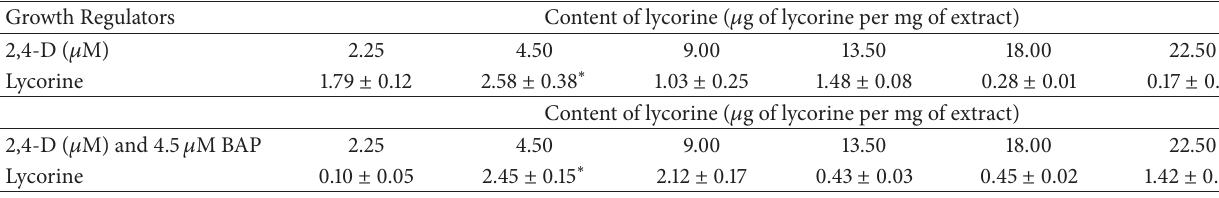
Table 3: Content of lycorine (dry weight) in the extracts of H. littoralis callus samples. Growth